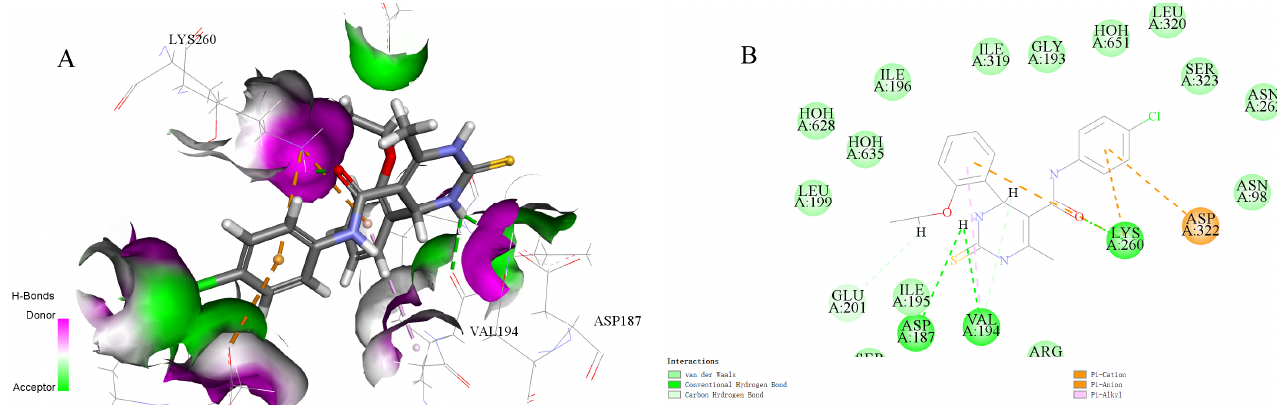
Figure 2. ( A ) The 3D view of the binding mode between the positive control monastrol and kinesin Eg5; the pink and green zones represent the hydrogen bond interactions. ( B ) The schematic diagram generated using the 2D diagram of Discovery Studio 4.1 shows the interactions between the positive control monastrol and the neighboring residues of kinesin Eg5.